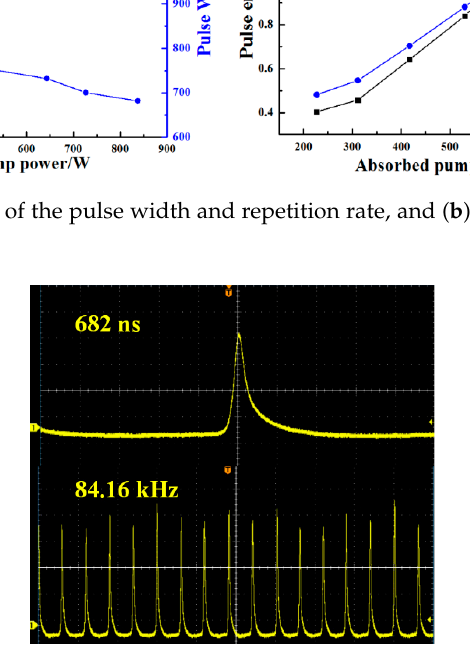
Figure 6. The pulse profile of the Q-switched laser.